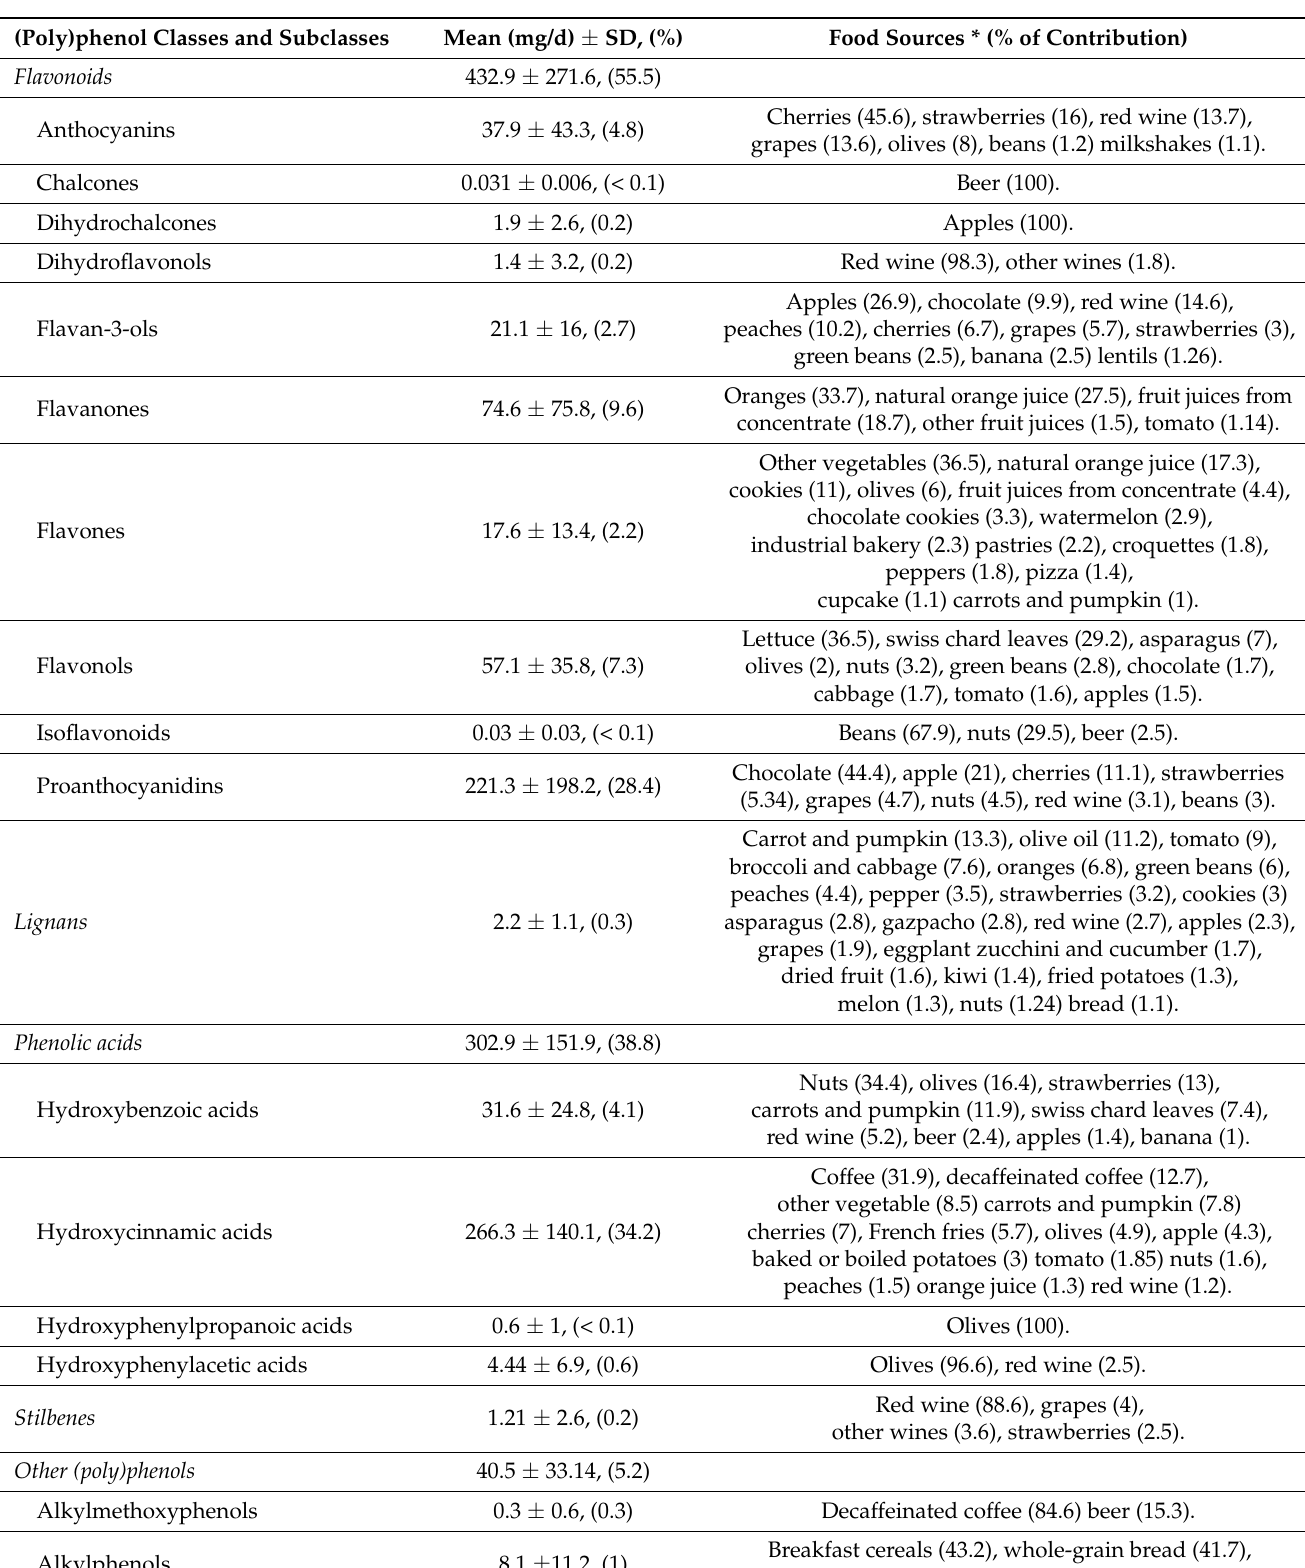
Table 2. Contribution of (poly)phenol subclasses to total (poly)phenol intake and dietary